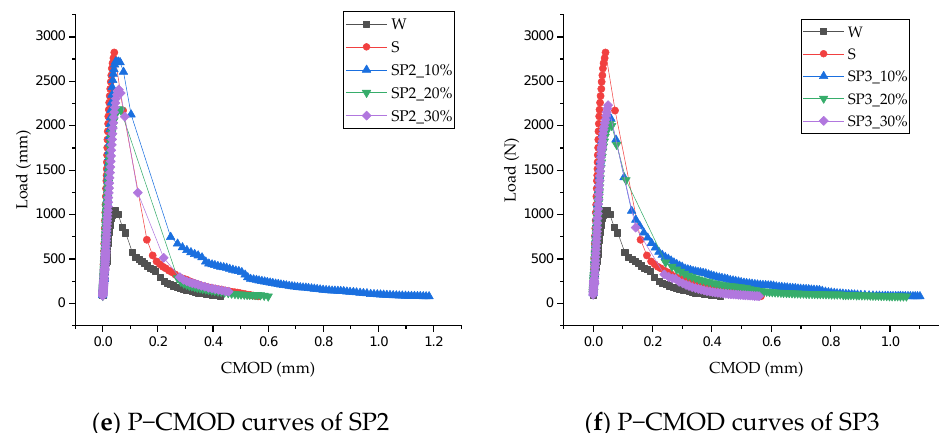
Figure 12. P−L and P−CMOD curves of the CMPC.